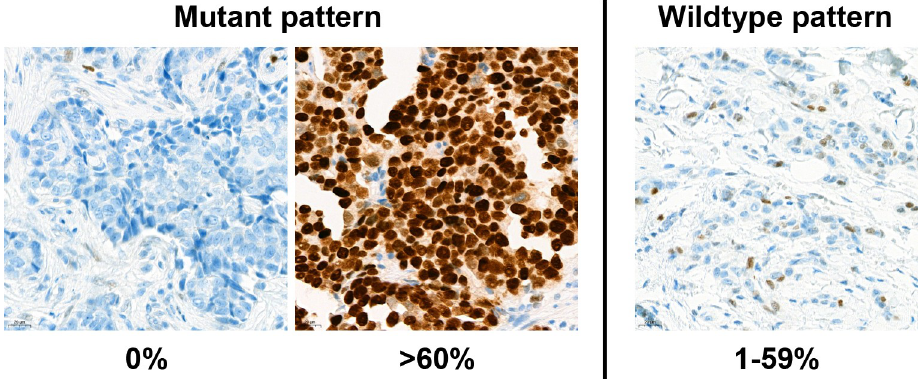
Fig 2. Expression pattern of p53. (Left) Mutant p53 pattern was defined when tumor completely loss of p53 expression or more than 60% of tumor cells had nulear p53 expression. (Right) Except for mutant p53 pattern, various random expression ranged from 1% to 59% of p53 nuclear expression was considered as wild-type expression